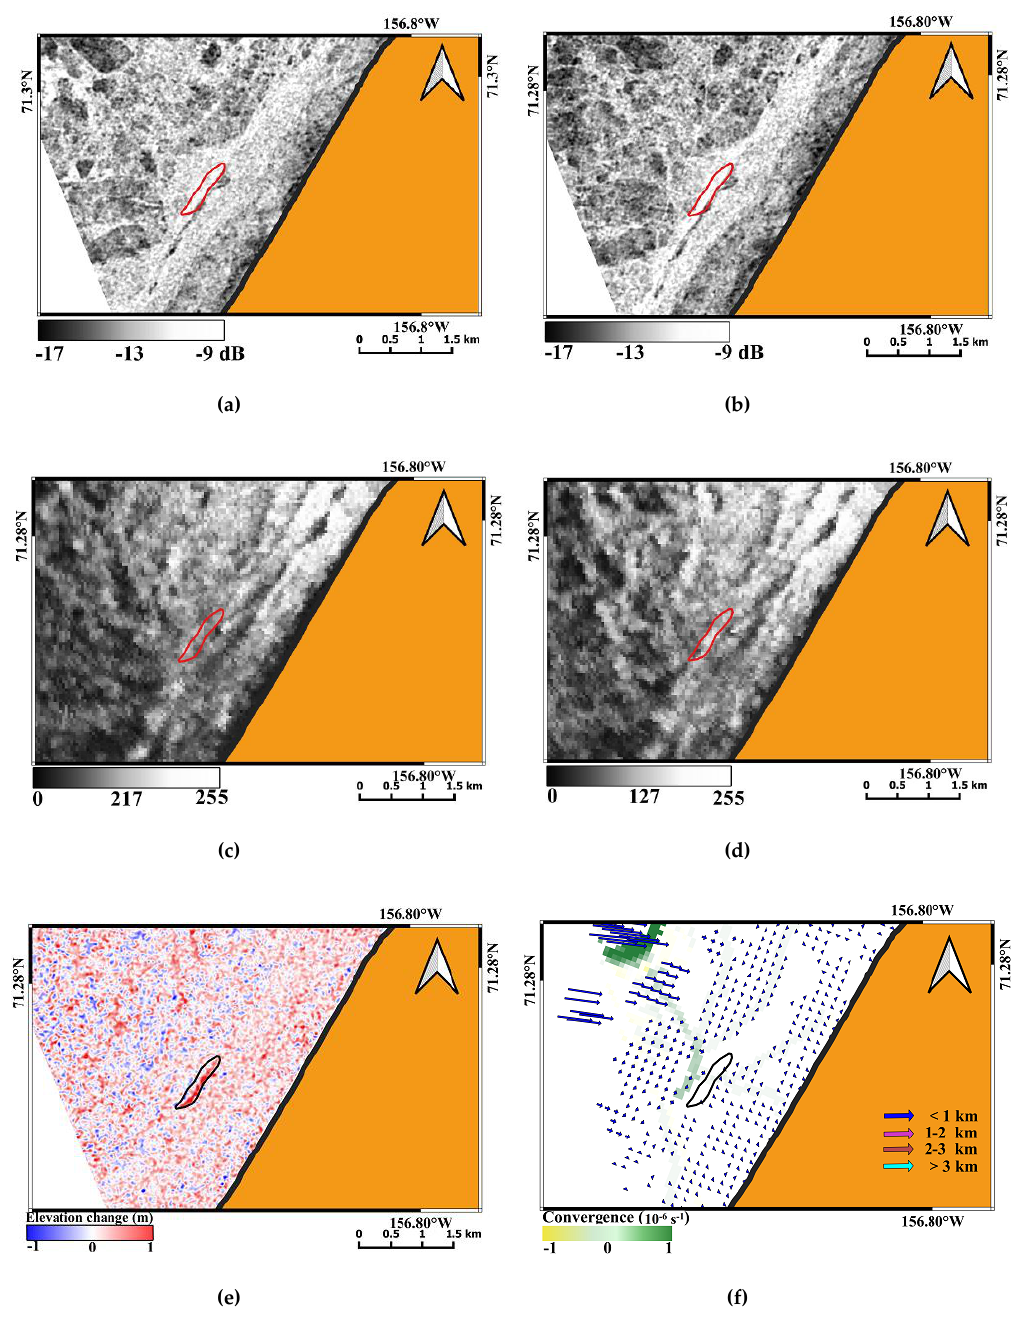
Figure 12. SAR backscatter intensity on 13 Jan ( a ) and 24 Jan 2012 ( b ). Coastal radar images on 13 Jan ( c ) and 24 Jan 2012 ( d ). The HDM is displayed in ( e ). Results from the drift algorithm are displayed as motion vectors and convergence zones ( f ). Red and black outlines in panels ( a – f ) signify the area of ridge development. Land is masked out in orange.